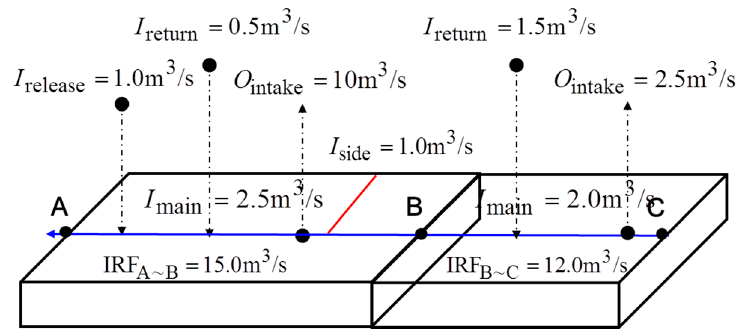
Figure 8. Example of the calculation of RMF.